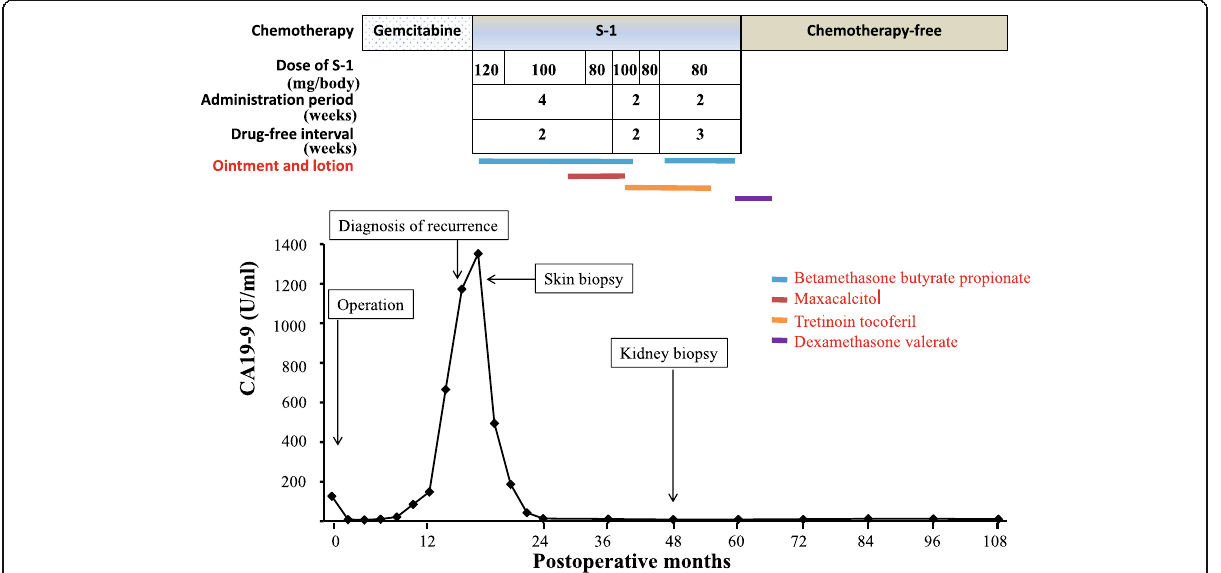
Fig. 2 Clinical course, postoperative changes of CA19-9, and dose and schedule of S-1 chemotherapy